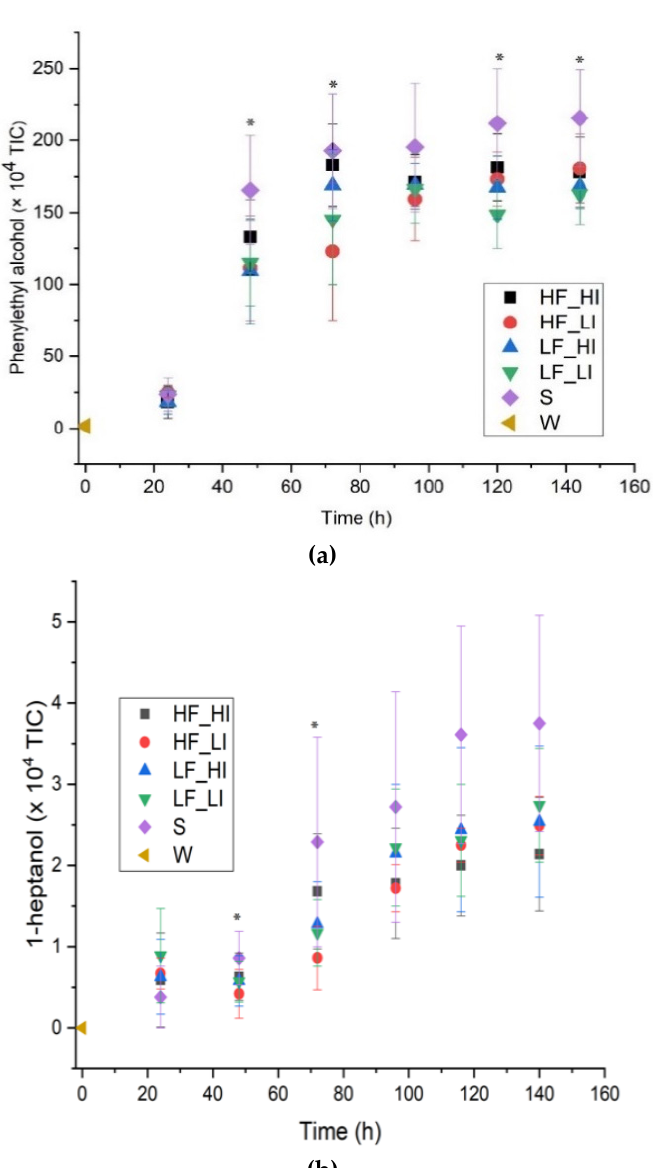
Figure 4. Abundance of higher alcohols during fermentation for five sound treatments including a silent control. ( a ) Phenylethyl alcohol (A32); ( b ) 1-heptanol (A15). Low-frequency and low-intensity (LF_LI); low-frequency and high-intensity (LF_HI); high-frequency and low-intensity (HF_LI); high-frequency and high-intensity (HF_HI); silence (S); wort (W). The results shown are means ± standard deviations of six measurements (3 biological fermentation replicates × 2 analytical replicates). * Significant difference observed (Table A1).